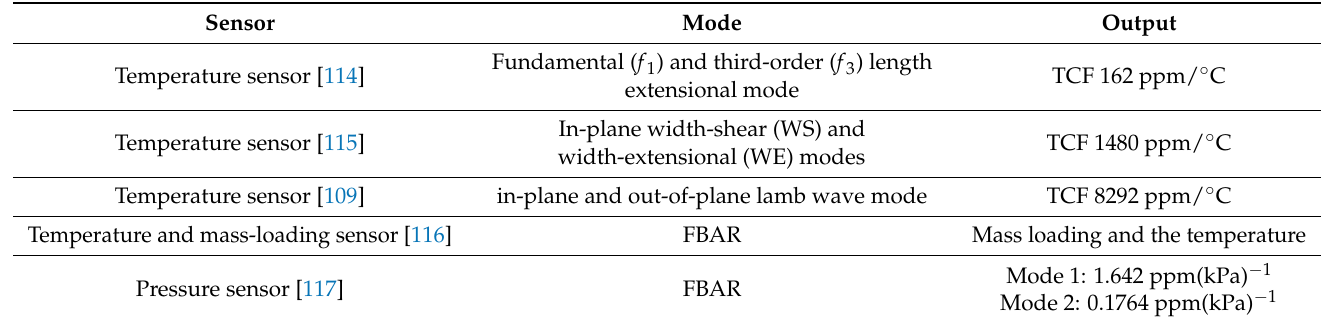
Table 8. Comparisons of Q-UCRB